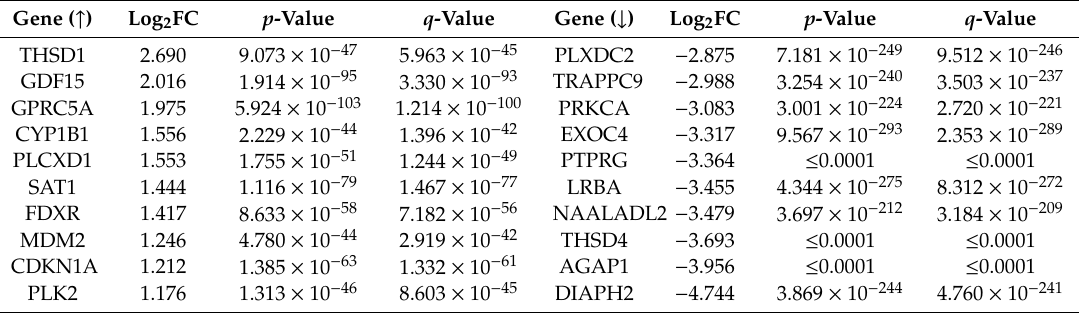
Table 4. Phenanthriplatin and cisplatin modulate gene regulation in IMR90 cells. Top 10 up- and downregulated DEGs for IMR90 cisplatin versus IMR90 control. DEG data analysis: ( p ≤ 0.05; q ≤